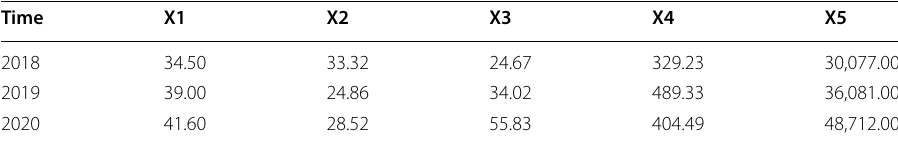
Table 6 5 data of indicators